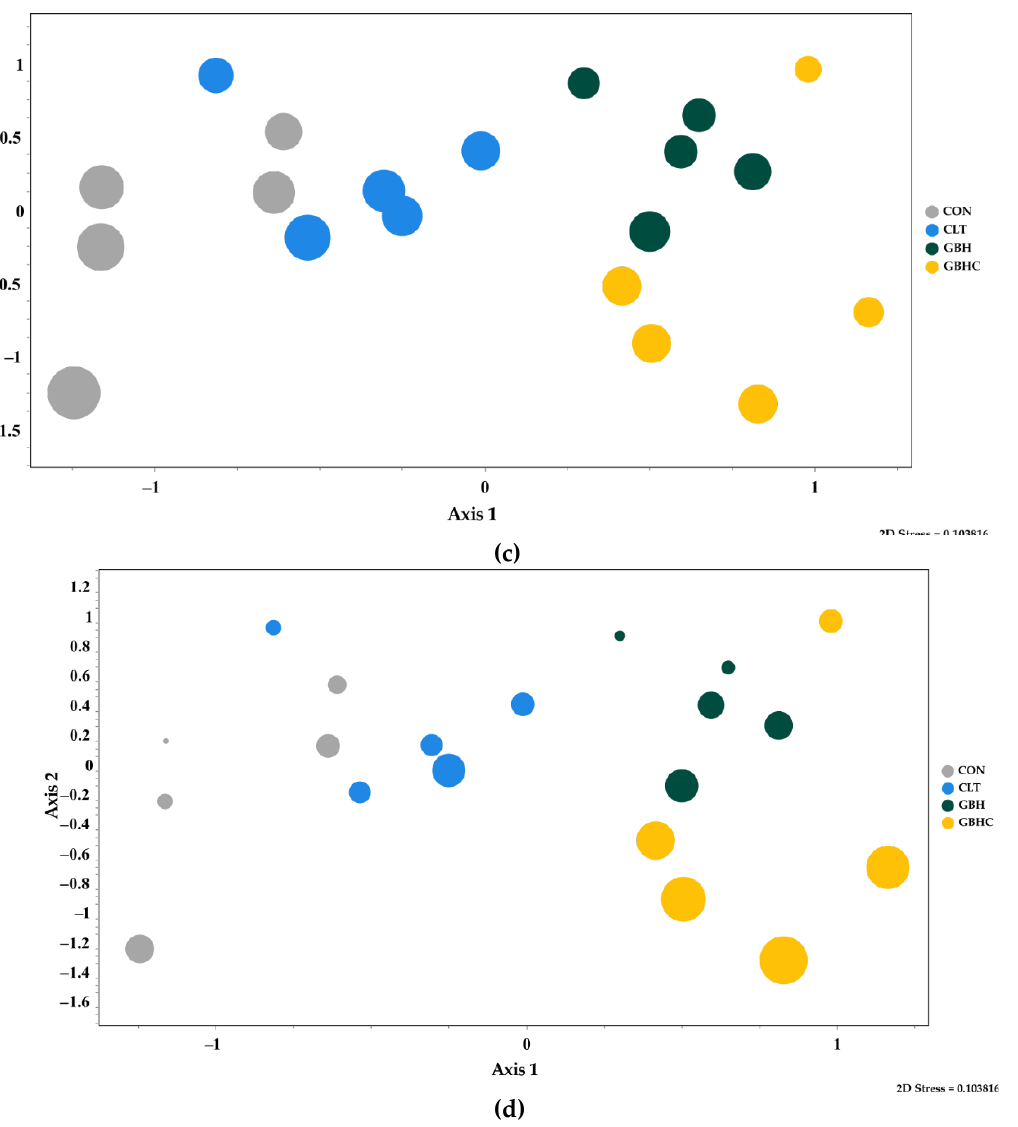
Figure 5. Axis 1 and 2 of NMDS, based on the relative abundance of pennate diatoms grown in flumes using inocula from the Mill Stream, a tributary of the River Frome, Dorset, UK. Control (CON), chlorotoluron (CLT), glyphosate-based herbicide formulation (GBH), and the combined application glyphosate-based herbicide formulation + chlorotoluron (GBHC); each bubble represents different flume replicates for each treatment ( n = 5): bubble plots of ( a ) the small naviculoid diatoms in the ‘sNav’ category, including Mayamaea atomus , Sellaphora nigri , Fistulifera saprophila and other poorly silicified taxa that fell within the same size range (<10 µm length); ( b )the pooled category of diatoms assigned to Nitzschia palea and N. paleacea (‘Nipp’) ; ( c ) the relative abundance of Achnanthidium minutissimum; d ) the relative abundance of an adnate group comprising Cocconeis lineata , Planothidium frequentissimum , and P. rostratum (‘Copl’) .